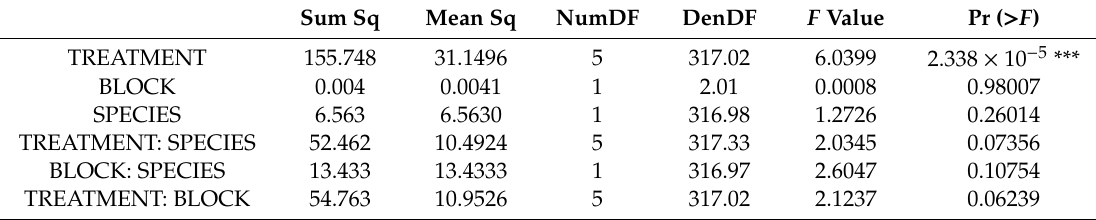
Table A1. Type III Analysis of Variance Table with Satterthwaite’s